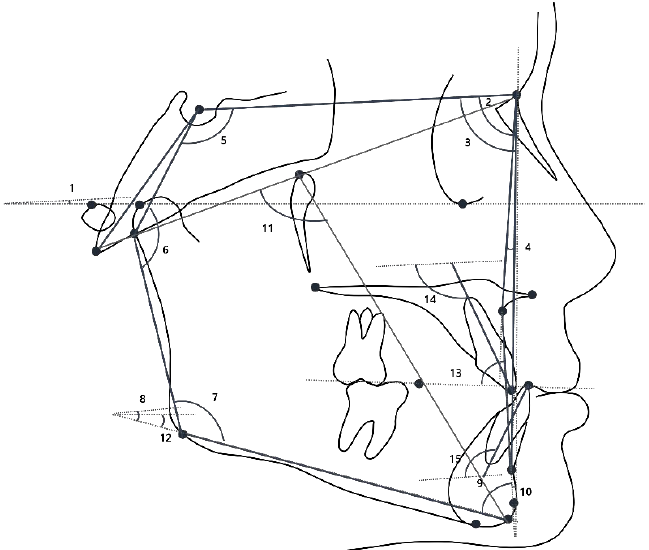
Figure 2. Linear measurements used in this study. 1, anterior cranial base; 2, posterior cranial base; 3, A point to N perpendicular; 4, pogonion to N perpendicular; 5, intermaxillary position to occlusal